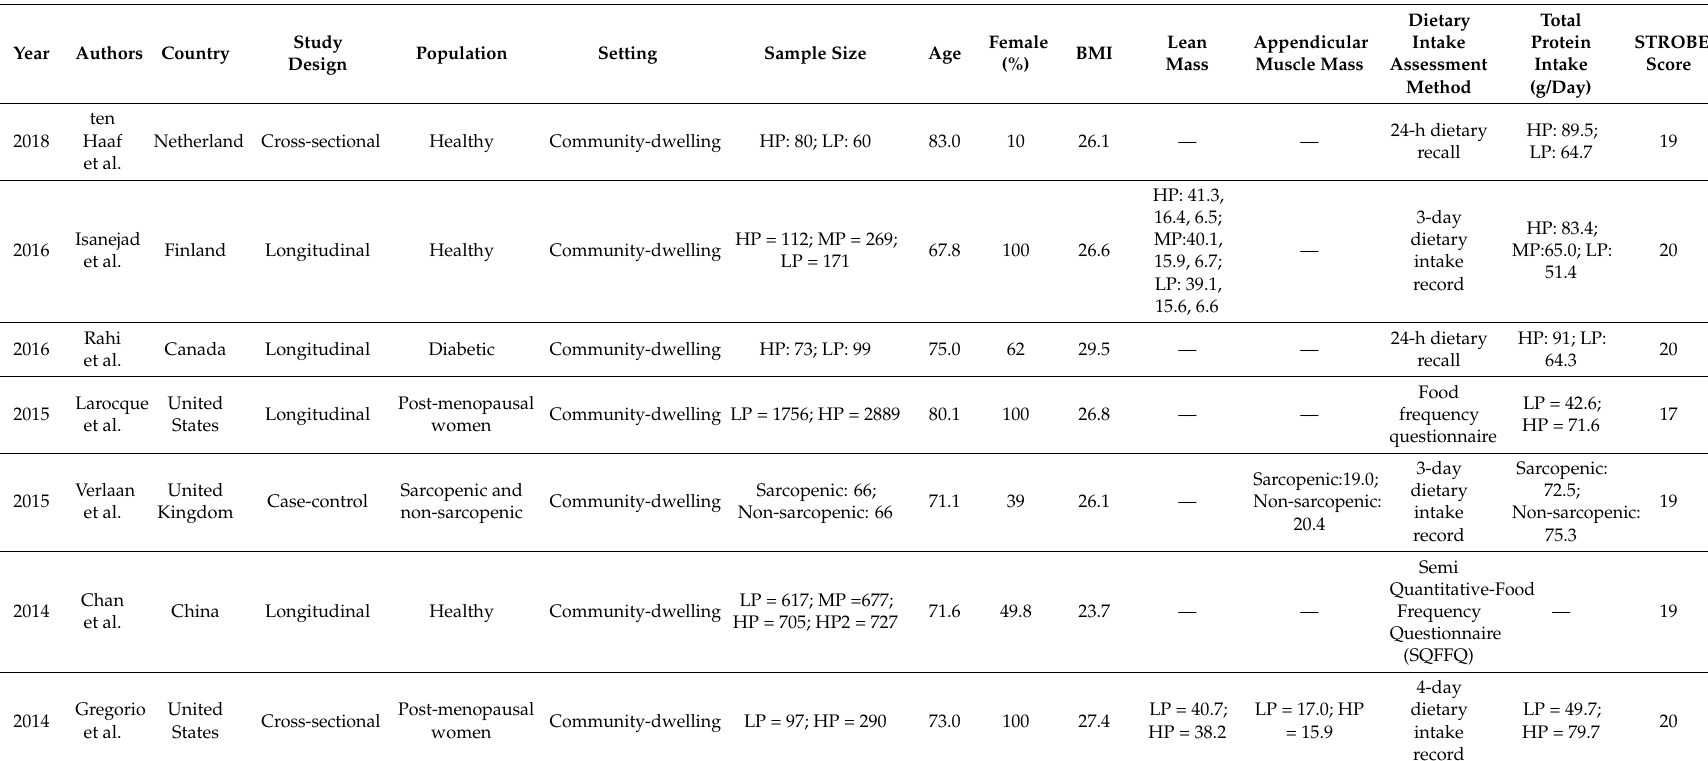
Table 1. General description of the included